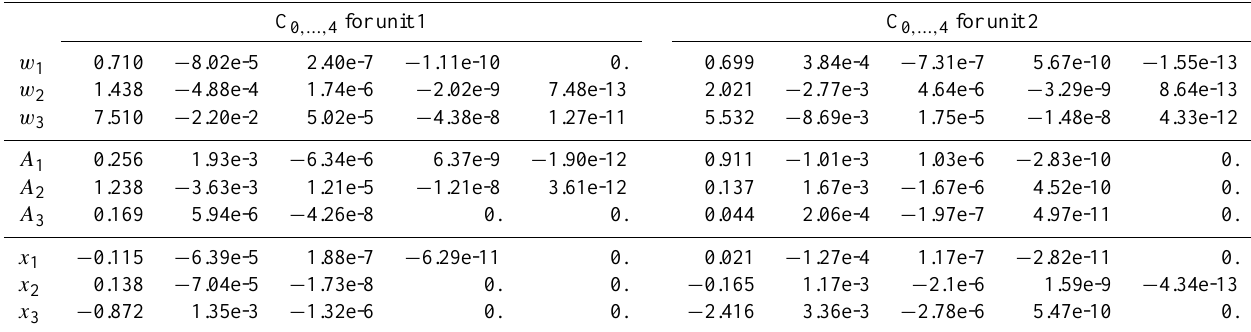
Table 6. Polynomial coefficients used to calculate the channel response function for AOS units 1 and 2 (Eqs. A1 and A2). C 0 ,..., 4 for unit 1 C 0 ,..., 4 for unit